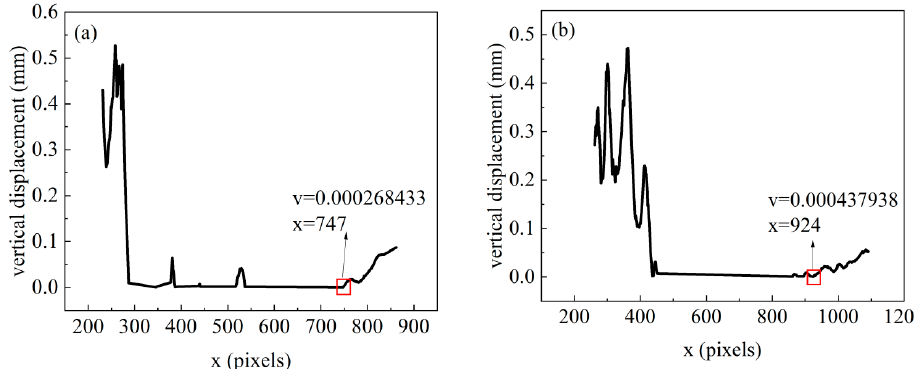
Figure 4. Variation in vertical displacement with x-coordinate on the crack line of specimens B1 and W1: ( a ) specimen B1 ( a = 25.02 mm); ( b ) specimen W1 ( a = 24.48 mm).